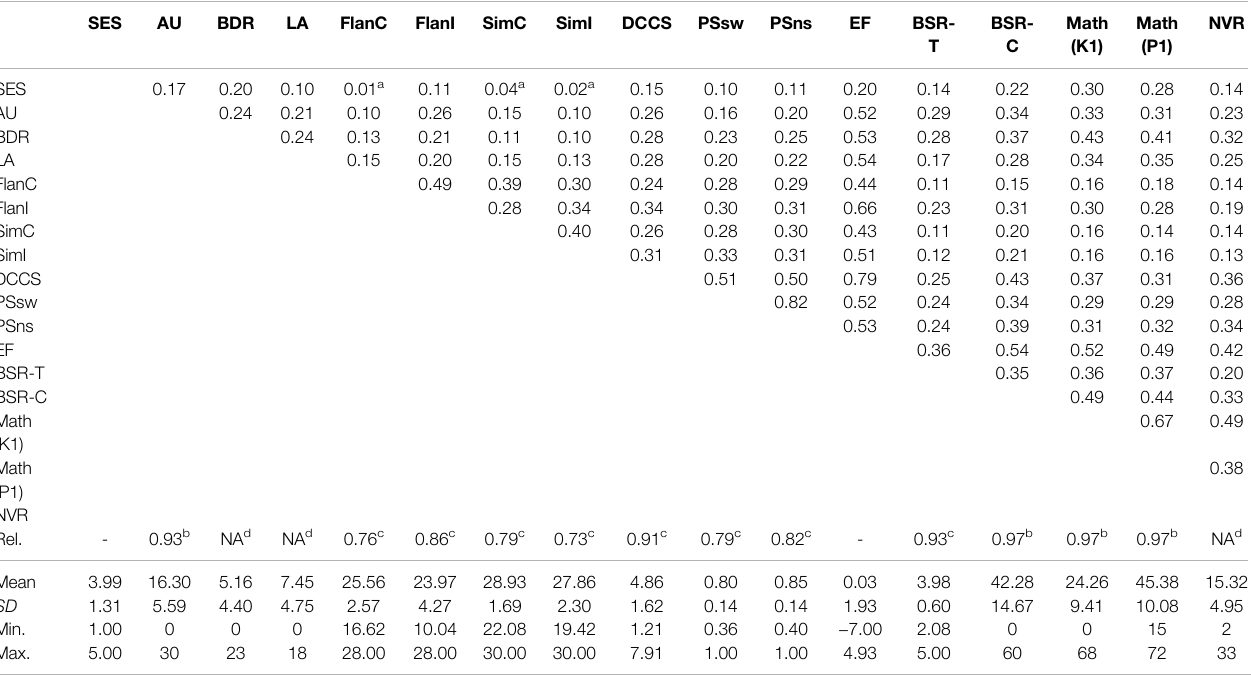
TABLE 1 | Descriptive statistics, inter-correlations, and reliabilities of the study variables. SES AU BDR LA FlanC